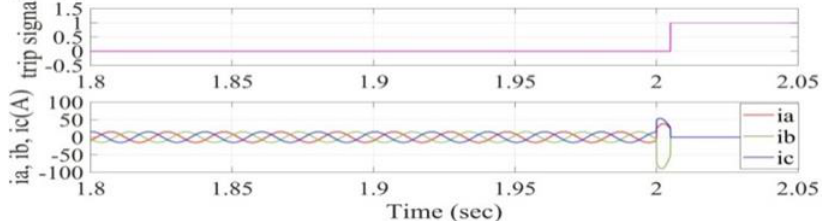
Figure 29. Stator current signals and trip signal waveforms for phase (c) to ground fault with load condition.